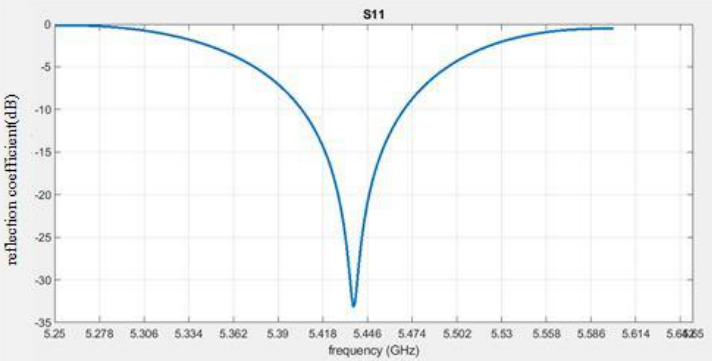
Figure 4: Input impedance versus frequency calculated by FDTD